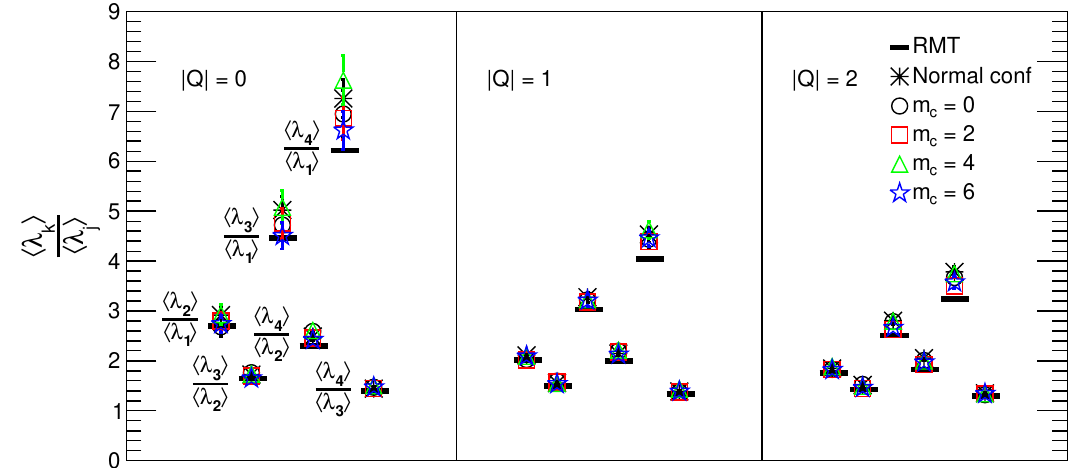
with the prediction of the chRMT k